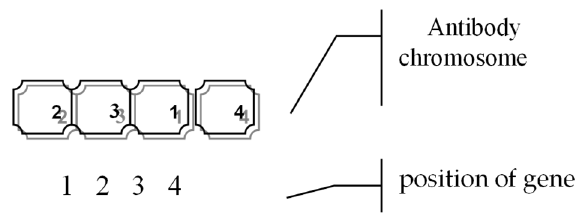
Figure 3. Chromosome coding.